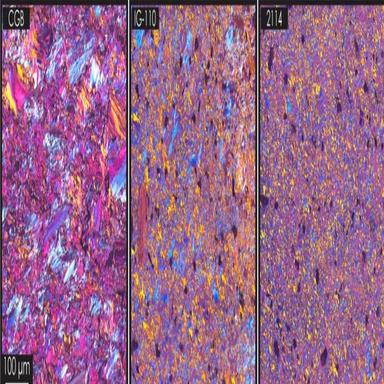
Polarized optical micrographs of CGB, IG-110, and 2114 graphite grades. The purple, blue and yellow regions are the mixture of filler and binder regions in different orientations; black regions are pores.